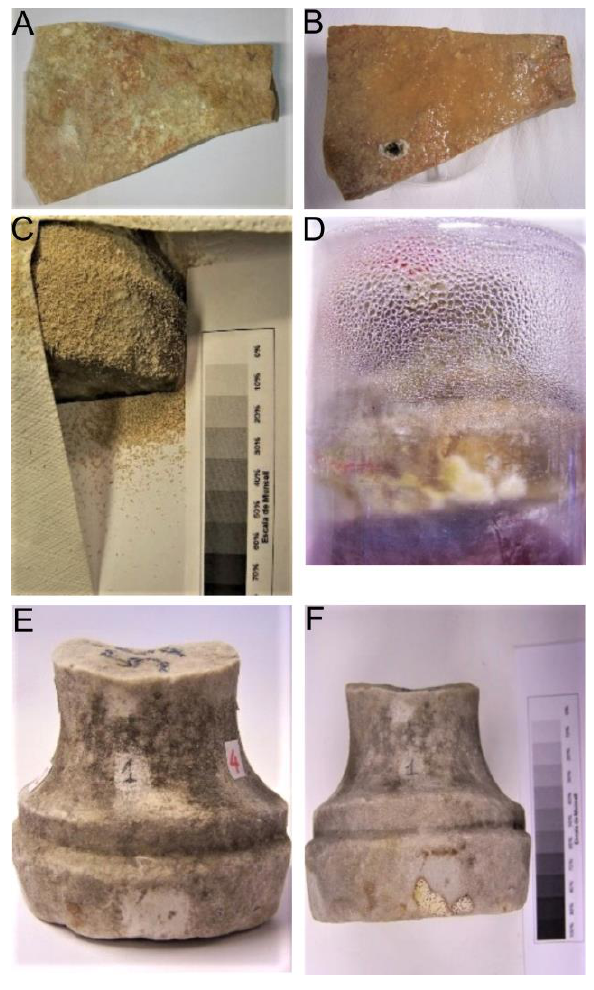
FIGURE 1: Laboratory scale dry biocleaning on two specimens. (Top) sample 1 (A – B), a common flat stone (carbonate stone) before and after yeast-sucrose addition; (middle) sample 2 (C-D), a CH marble fragment, after yeast-sucrose addition and detail of incubation in the Gas-Pak jar with condensation phenomenon; (bottom) sample 2 (E-F), the CH marble surface before and after the dry biocleaning